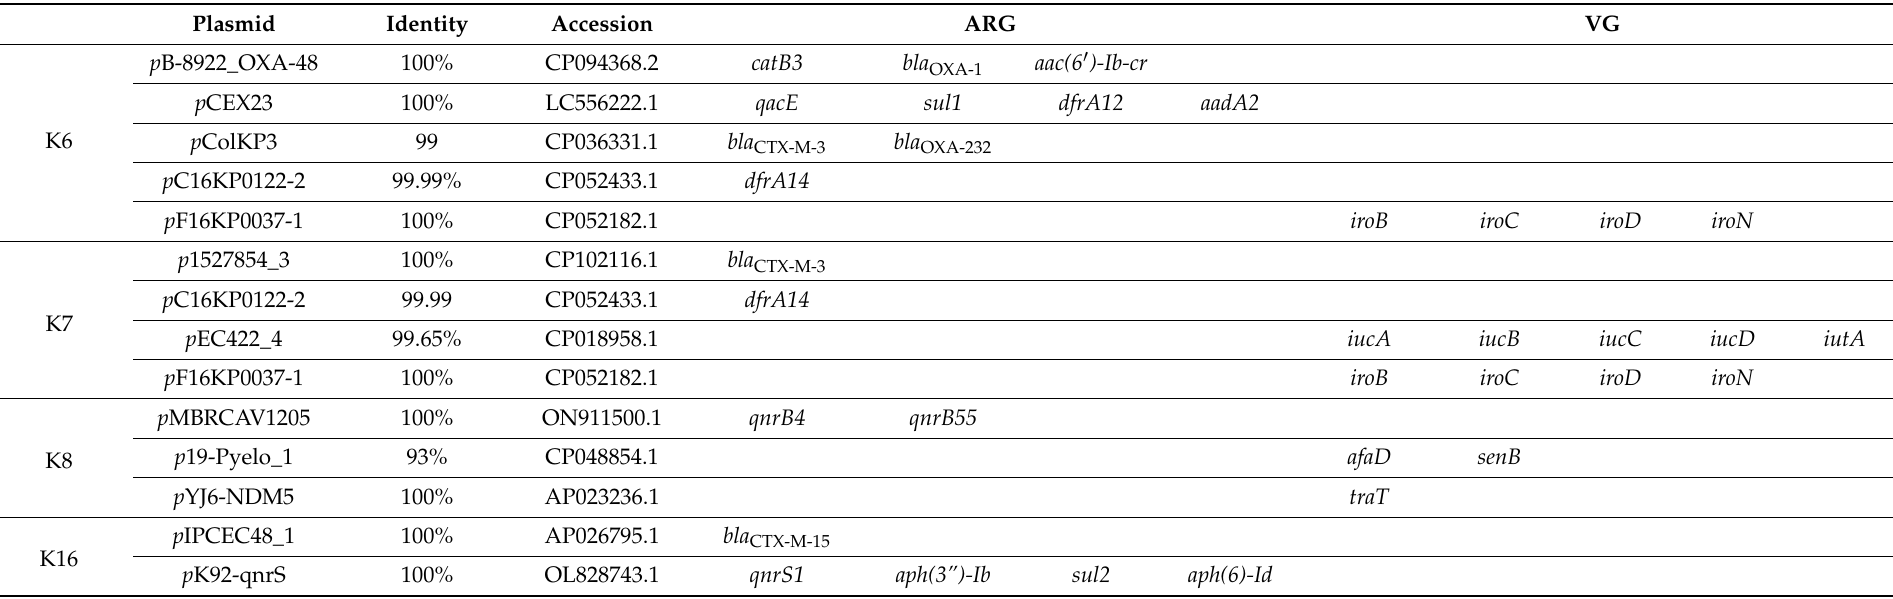
Table 3. Plasmids associated with antimicrobial-resistant genes (ARGs) and virulence genes (VG) in KP isolates.